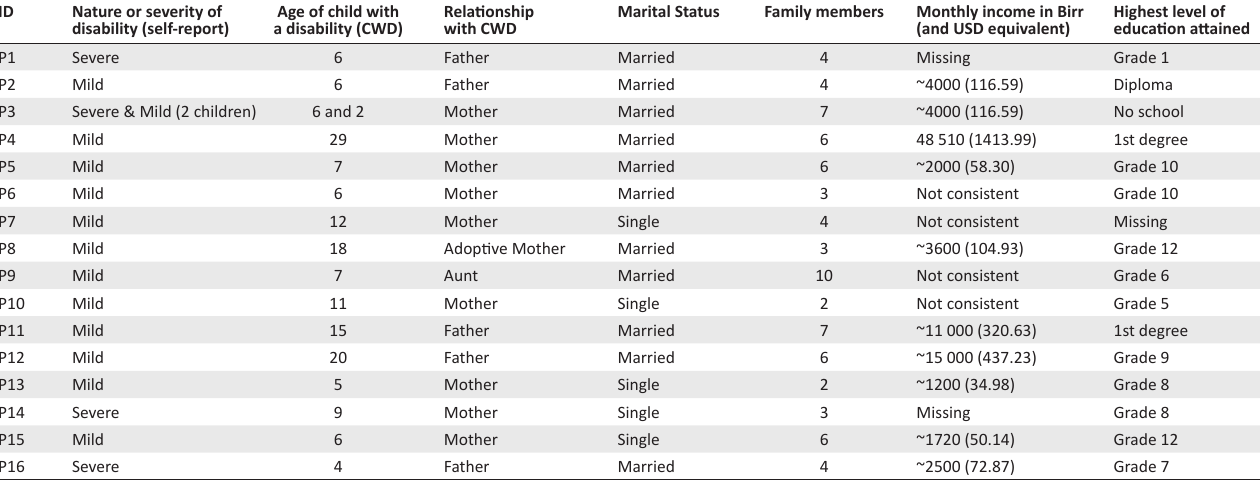
TABLE 2: Participant